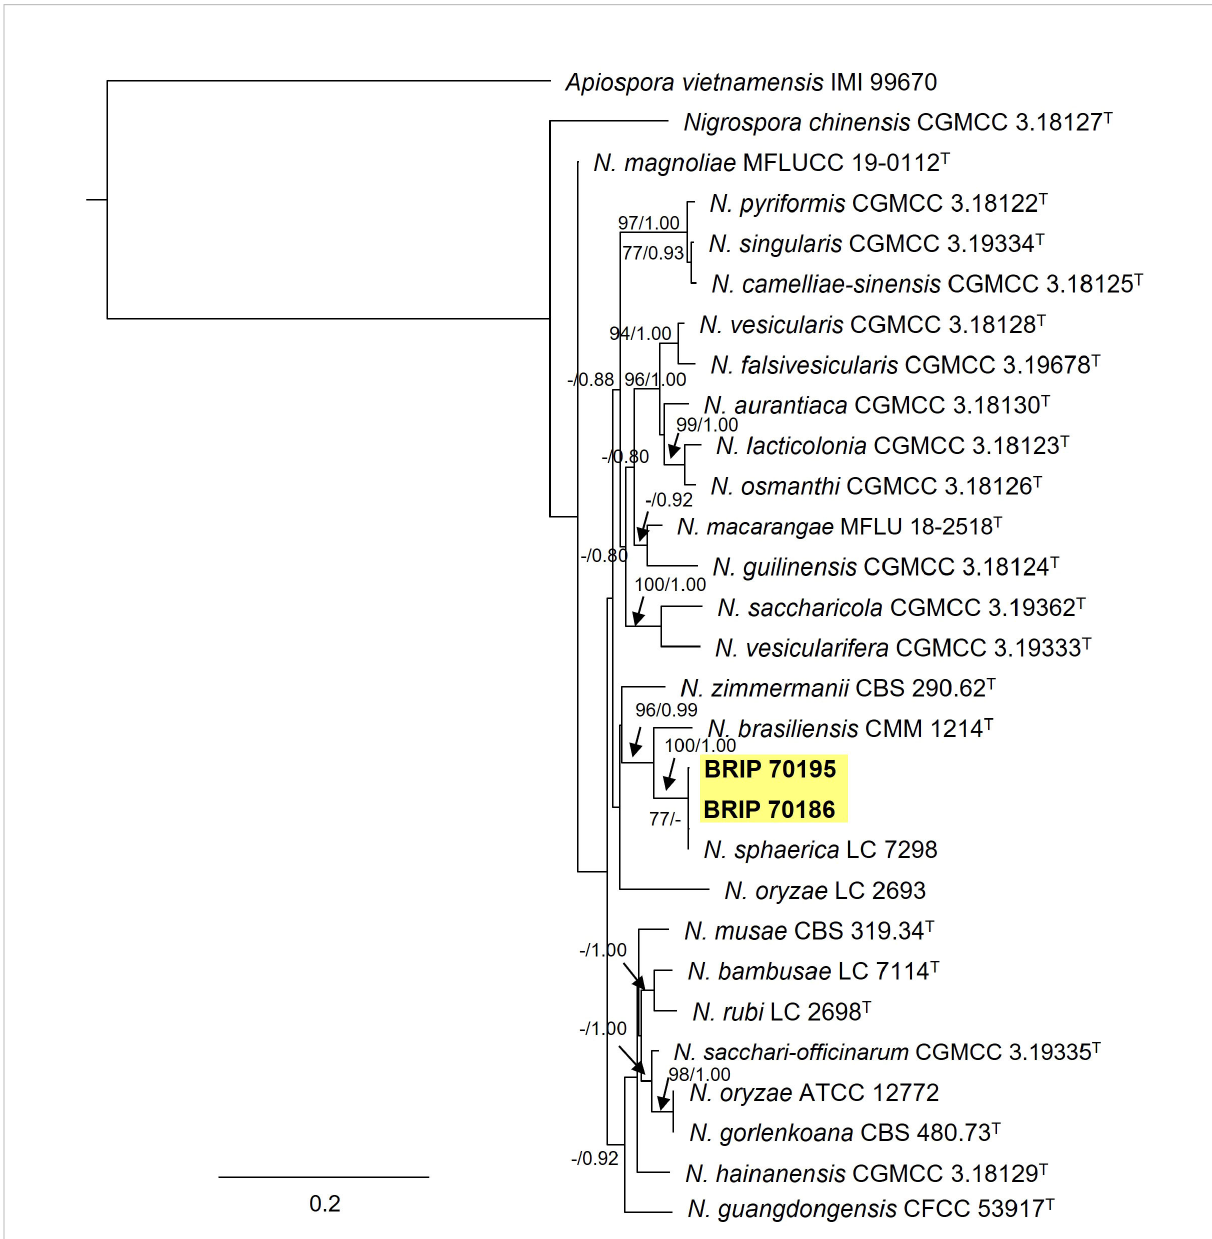
FIGURE 14 Phylogenetic tree inferred from a RAxML analysis based on a concatenated alignment of ITS, LSU and tef1- a sequences of related species in Trichosphaeriaceae (Trichosphaeriales). RAxML bootstrap (bs) values greater than 70% and Bayesian posterior probabilities (pp) greater than 0.8 are given at the nodes (bs/pp). In bold font are the isolates from this study, and ex-type strains are indicated with T